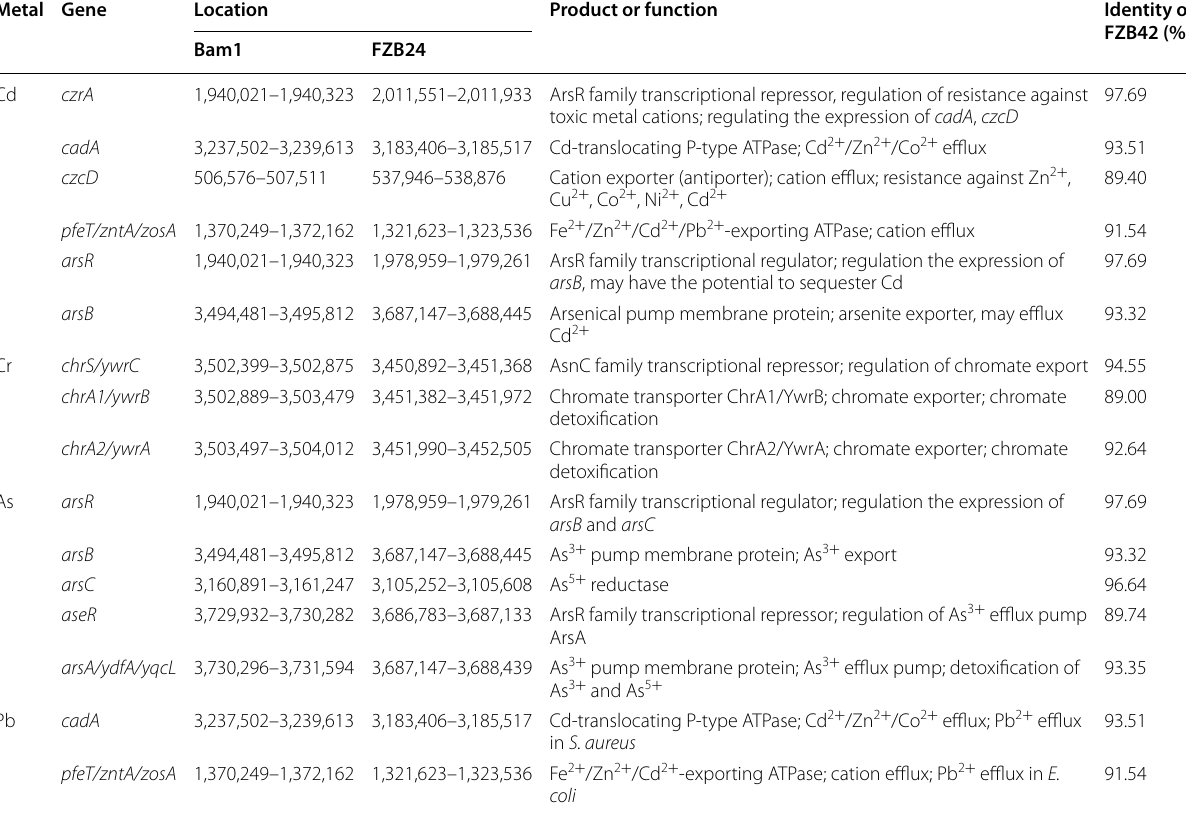
Table 6 Genes involved in Cd, Cr, As and Pb resistance in B. amyloliquefaciens strain Bam1 and B. velezensis strain FZB42 Metal